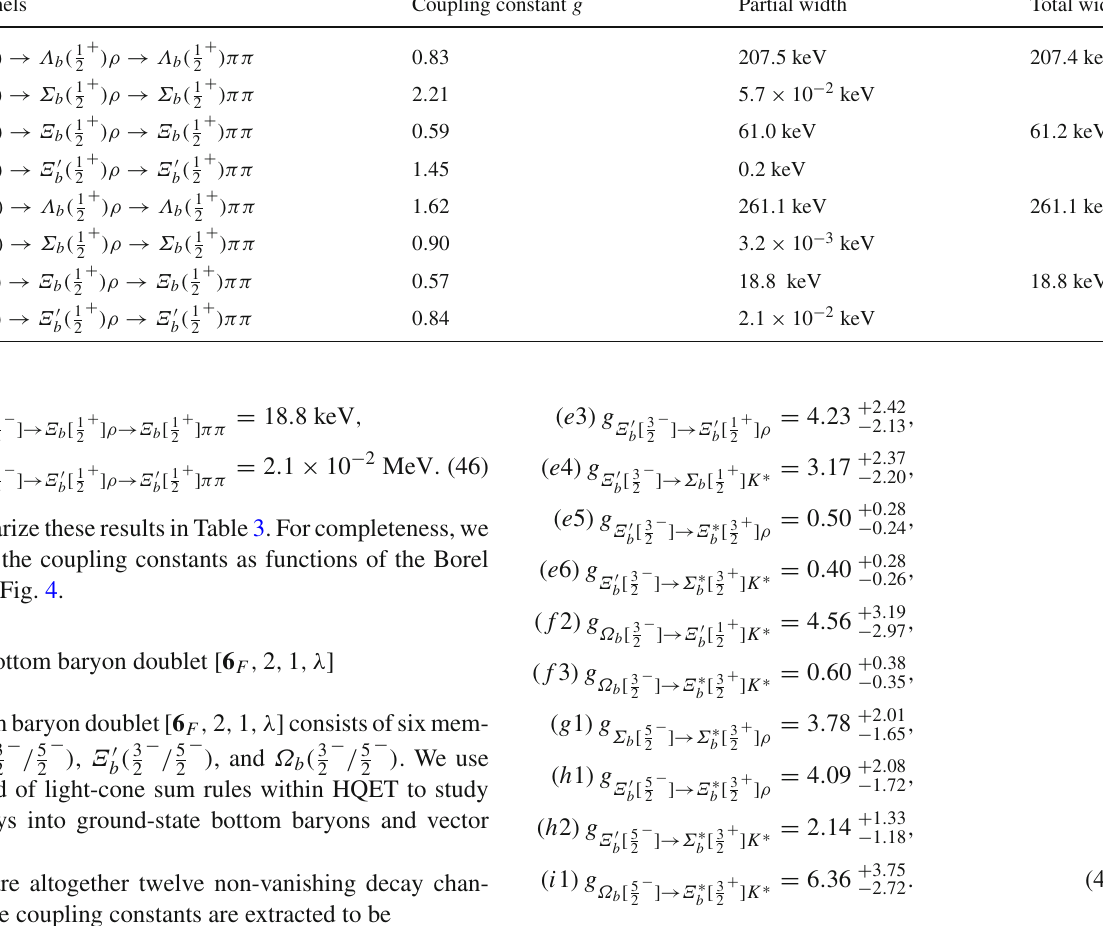
( a ) (b) Fig. 3 The coupling constants a g and b − ]→ Σ 0 Σ − [ 1 ρ − b b 2 g as functions of the Borel mass T . Here the − ]→ Ξ (cid:4) 0 Ξ (cid:4)− [ 1 ρ − b b 2 − ) − ) ( 1 and Ξ (cid:4) belong to the bottom baryon sin- baryons Σ b ( 1 b 2 2 Table 3 S -wave decays of P -wave bottom baryons belonging to the doublet [ 6 F , 1 , 1 ,λ ] into ground-state bottom baryons and vector mesons Decay channels Coupling constant g Partial width Total